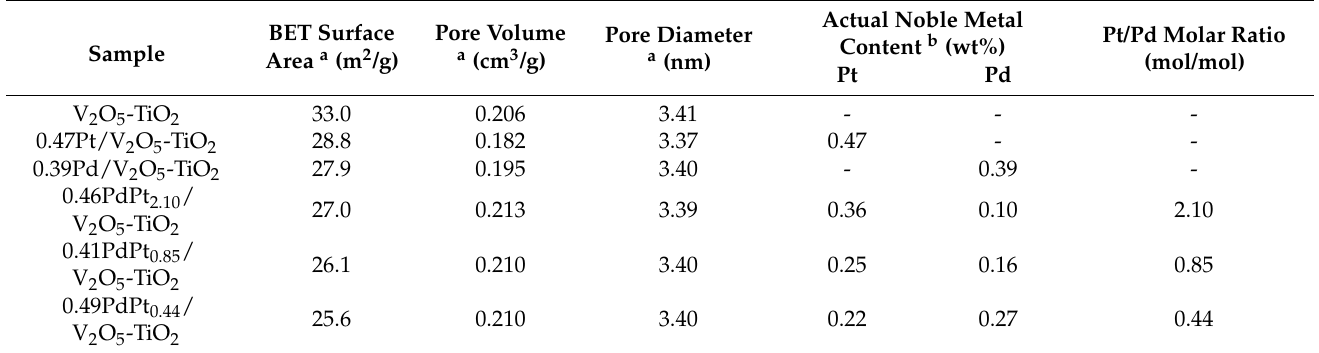
Table 1. BET surface areas, pore volumes, pore diameters, actual noble metal contents, and actual Pt/Pd molar ratios of the as-prepared